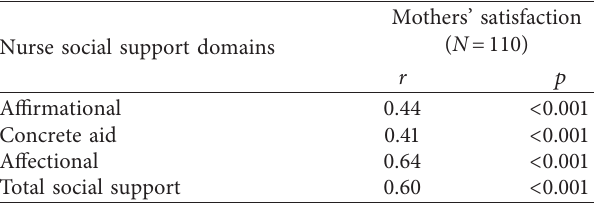
Table 4: Correlation coefficients of the Nurses Social support and mothers’ satisfaction from neonatal care in NICU. Nurse social support